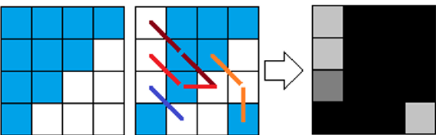
Fig. 2. Calculating the pixel distance example of the microphotograph classified section for a rasterized photomask area.